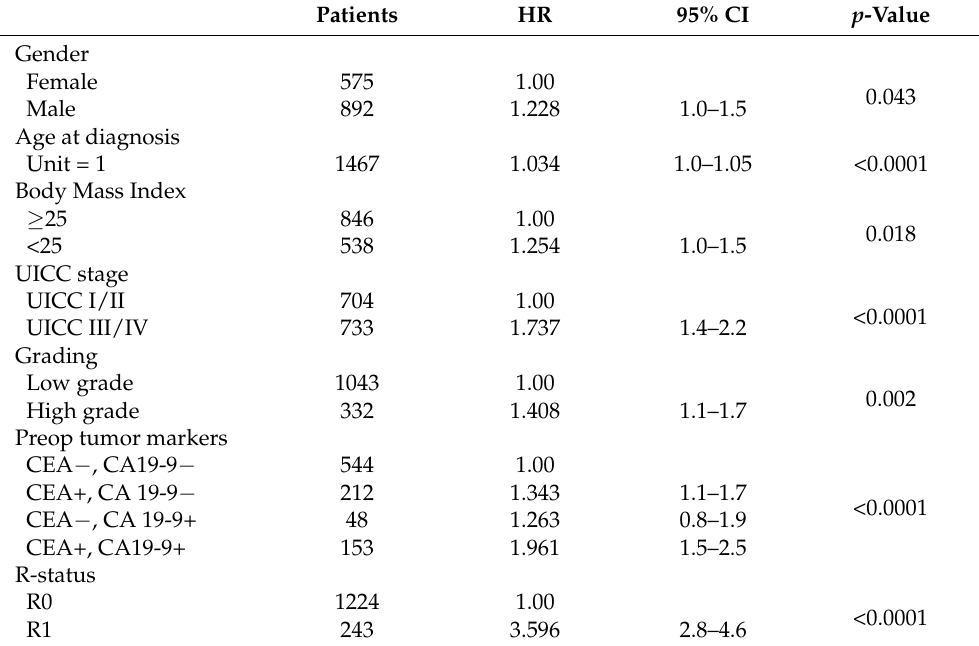
Figure 5. Kaplan–Meier curves showing the recurrence-free survival for patients that were R0 resected with both preoperative tumor markers below the cut-off value (turquois), with only CEA increased (blue), with only CA19-9 increased (green), and with both tumor markers increased (red). Table 3. Multivariate analysis for overall survival as the Cox proportional hazards